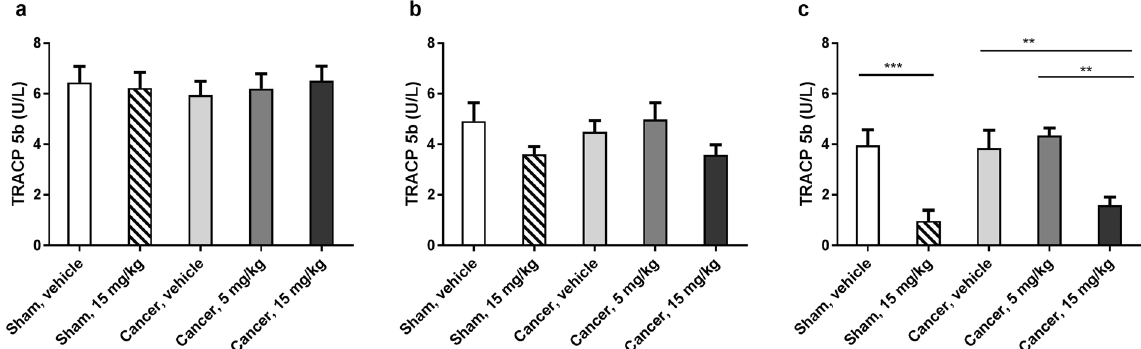
Figure 5. High dose dasatinib significantly lowers serum levels of TRACP 5b compared to vehicle treated controls. ( a ) There is no significant difference between the groups on day 6, i.e. one day before starting dasatinib treatment. ( b ) There is no significant difference between the groups on day 12, i.e. after 6 days of dasatinib treatment. ( c ) Serum TRACP 5b is significantly decreased in the high dose dasatinib treated groups compared to vehicle treated controls on day 23 post inoculation. Low dose dasatinib does not influence the serum TRACP 5b values compared to vehicle treated control. Ordinary one-way repeated-measurement ANOVA followed by Bonferroni’s multiple comparison test. The results are shown as the mean ± SEM, n =